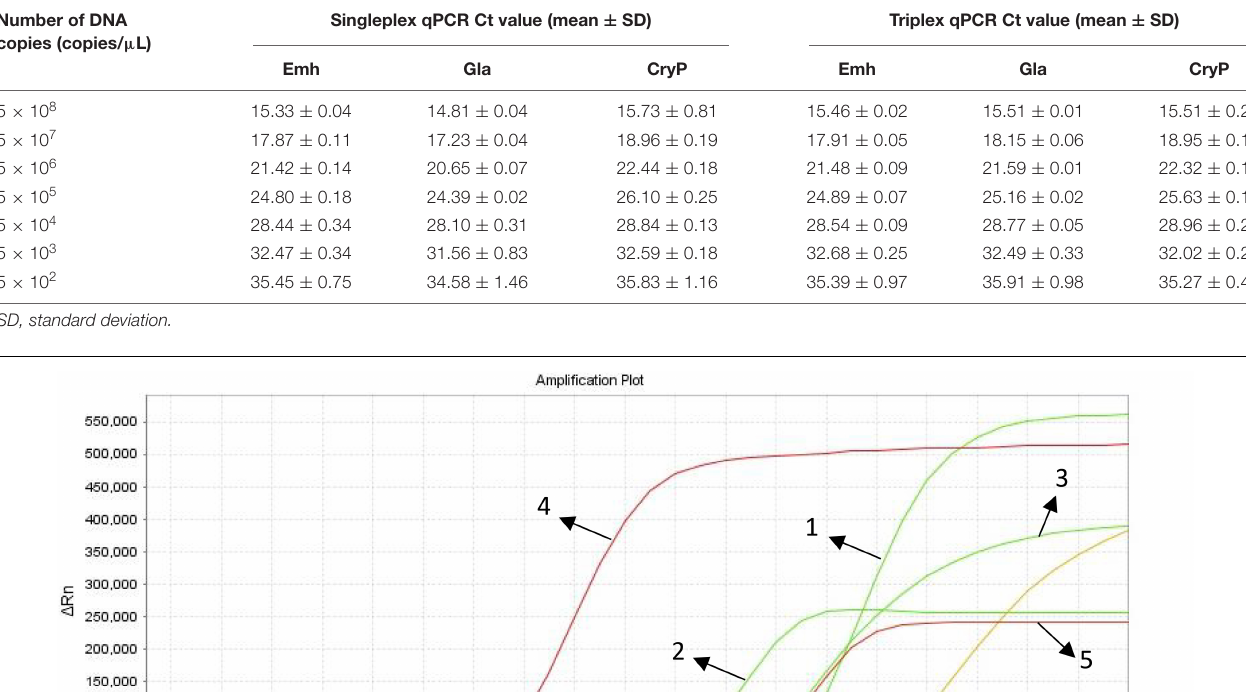
Frontiers in Microbiology |